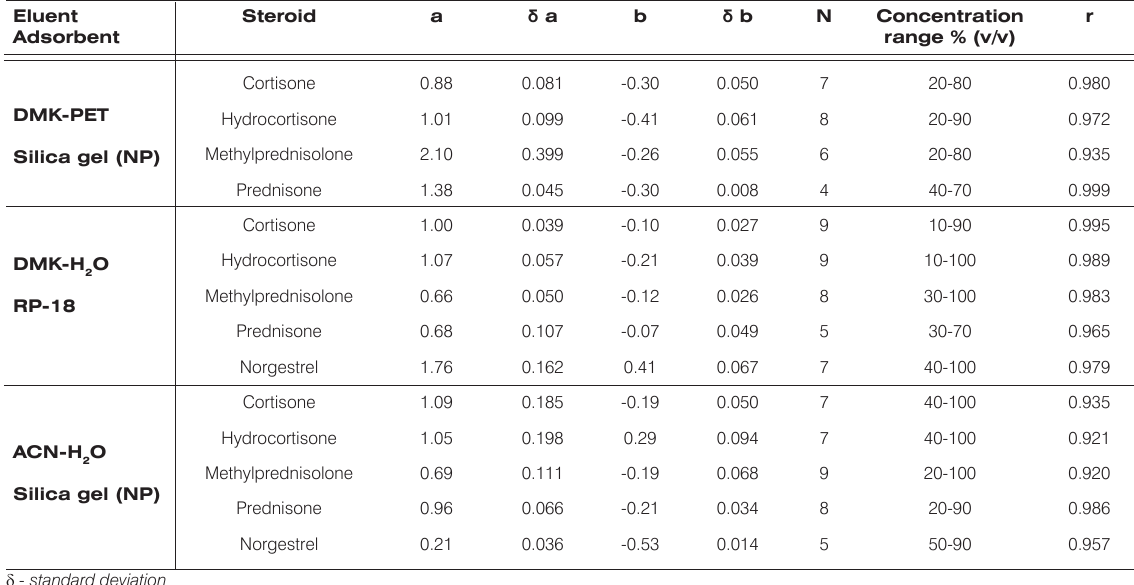
= a + b R = a + b R and R for steroid drugs with binary mobile phases ( NP – parameters R M CN M NP M CN M RP on reversed-phase, CN - parameters R on cyano-bonded silica stationary phase). M M